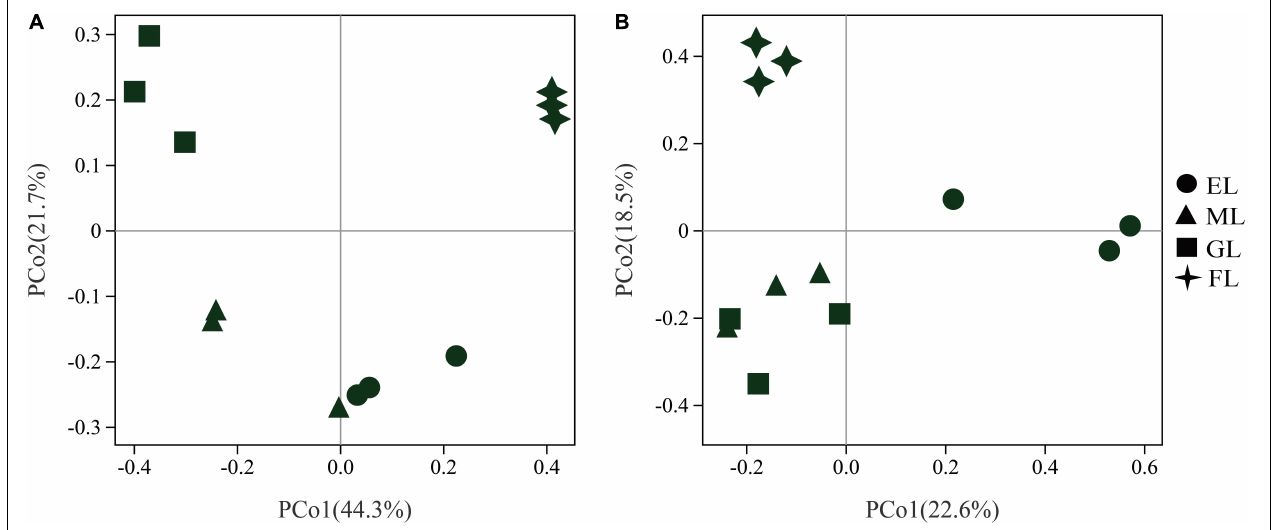
FIGURE 3 | Principal component analysis (PCoA) of bacterial (A) and fungal (B) communities in different land use types. EL, exclosure; ML, mowed land; GL, grazed land; and FL,